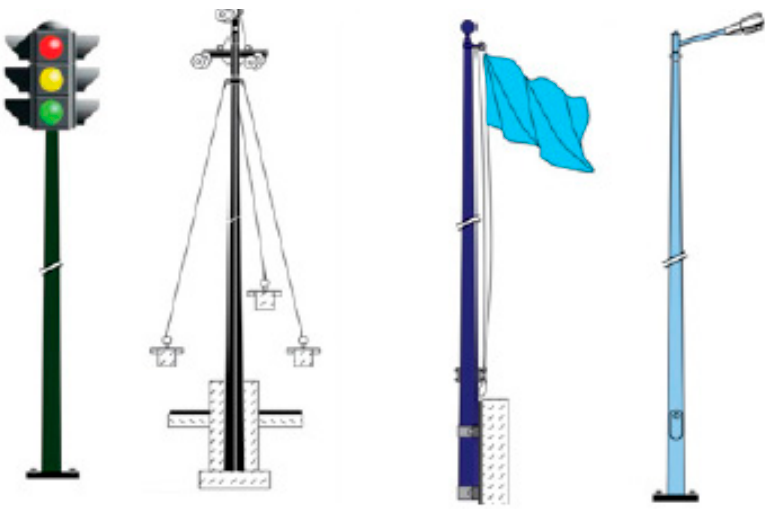
Figure 2. Different applications of poles.